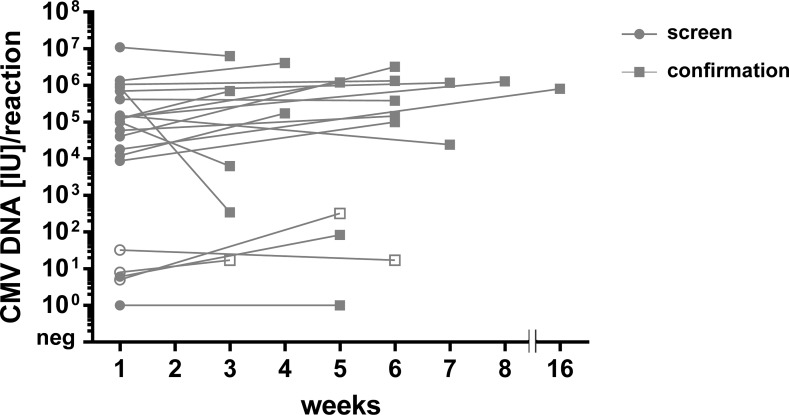
Course of CMV DNA load in saliva samples.The course of CMV DNA loads (IU/PCR reaction) in buccal swabs from screening and confirmatory testing is shown for each individual patient. Included were all patients with confirmed cCMV infection (n = 18, filled icons) as well as the three patients who were found to be CMV DNA positive in the buccal swab but not in blood and urine at time of confirmation (open symbols). Samples for CMV screening were taken within 3 days after birth (week 1, represented as gray circle). Sampling for confirmatory diagnostics was performed in five cases within in the recommended time frame of three weeks after birth and in 15 cases within three and eight weeks after birth (figured as gray square). In one case confirmatory diagnostics could only be done after 16 weeks.